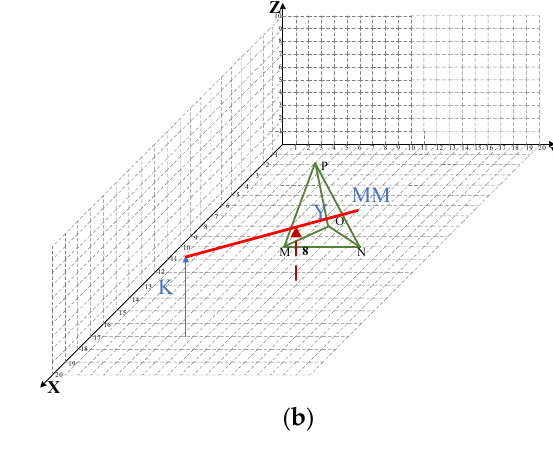
Figure 5. Environmental occlusion.